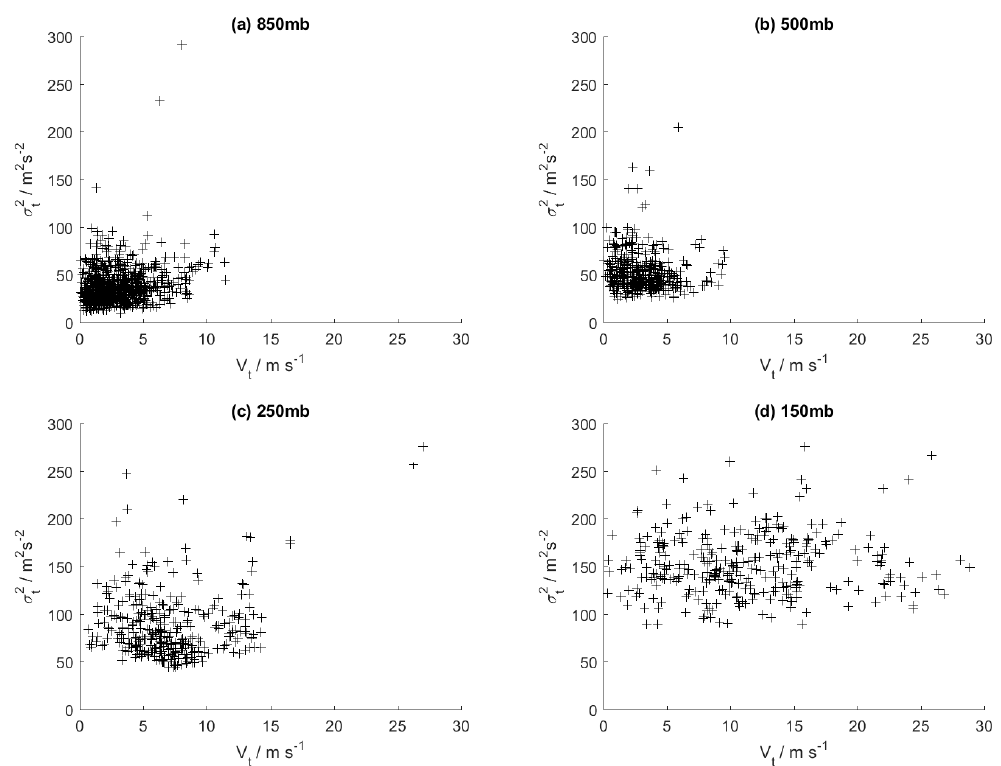
Figure 2. Scatters of σ 2 s vs. V s for four of the eleven standard pressure levels: ( a ) 850 mb; ( b ) 500 mb; ( c ) 250 mb; ( d ) 150 mb.